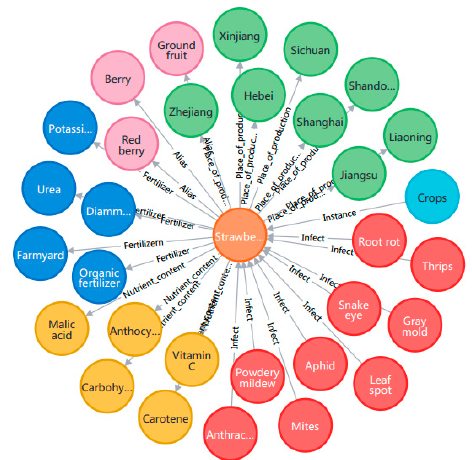
Figure 2. The portrait of strawberry based on graph databases. The light blue circle represents the crop entity, the orange circle represents the strawberry instance, the purple circles represent aliases, the dark blue circles represent fertilizers, the yellow circles represent nutrient contents, the red circles represent diseases and pests, and the green circles represent places of production.